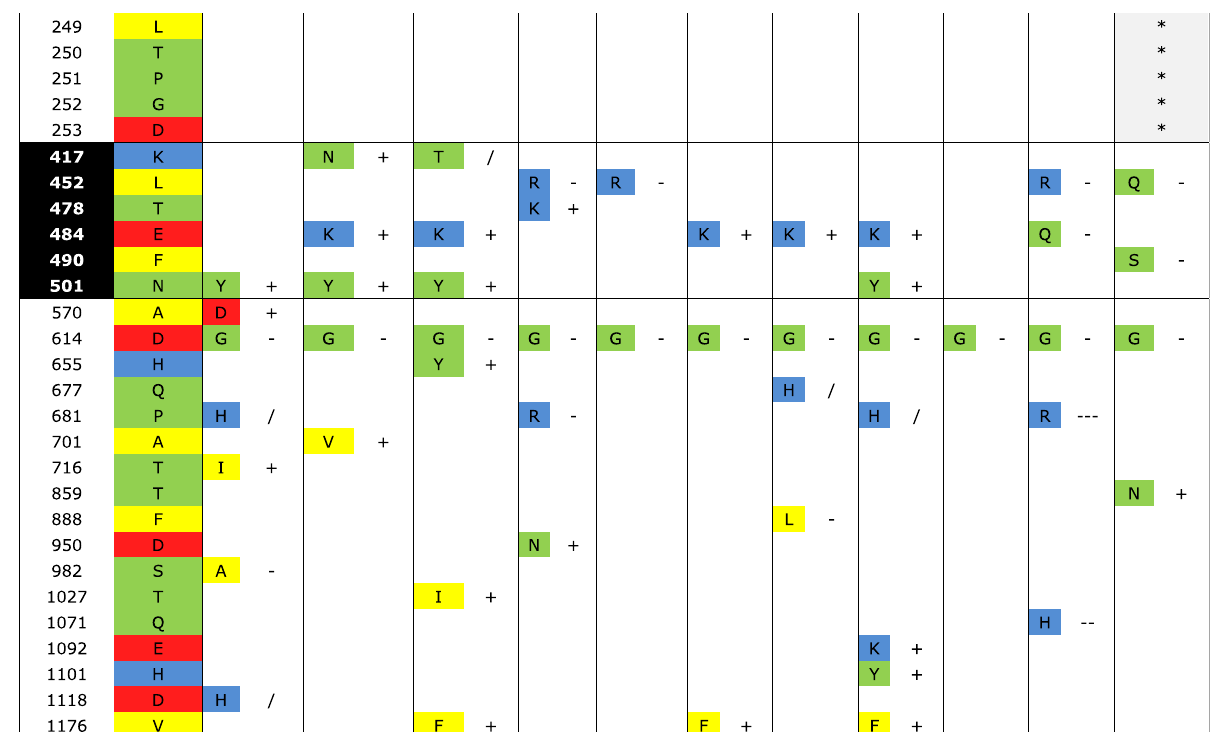
Table 3. Type of selective pressure for mutations in health concern variants. The mutations colored by physicochemical properties are enlisted for each variant and the type of selective pressure applied for each a.a. is shown. The type of pressure is specified either for the whole protein or for amino acids positioned in the RBD. "Position" column is according to the RefSeq. The substituting amino acid on each variant is indicated in one-letter code next and the selective pressure exerted over the a.a. according to the neutrality test. Positive (+), negative (−), neutral (/). Asterisks indicate